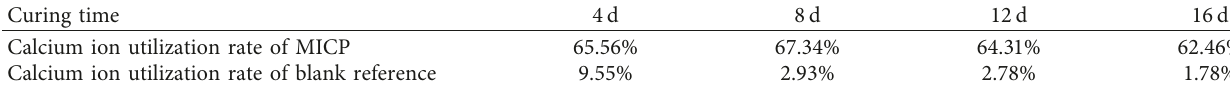
Table 2: Table of calcium ion utilization.